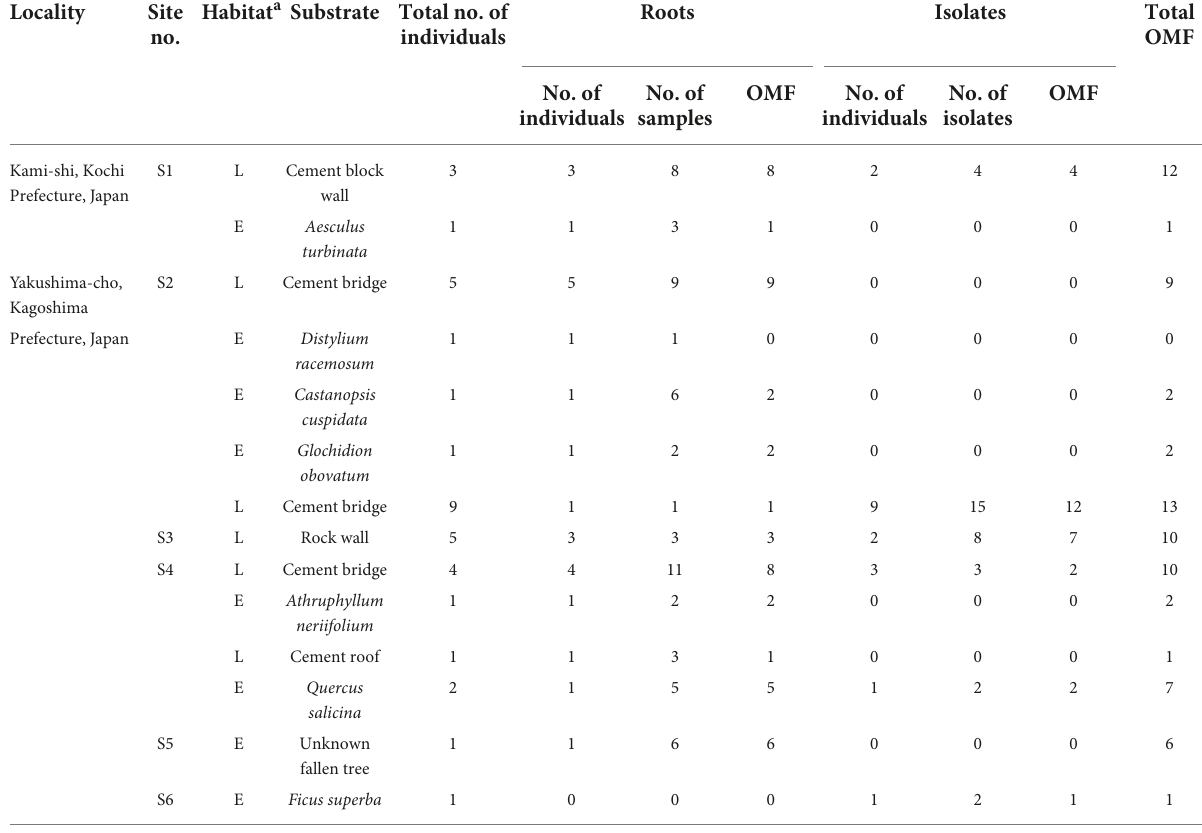
TABLE 1 Details of Dendrobium officinale and mycorrhizal samples used in this study. Locality